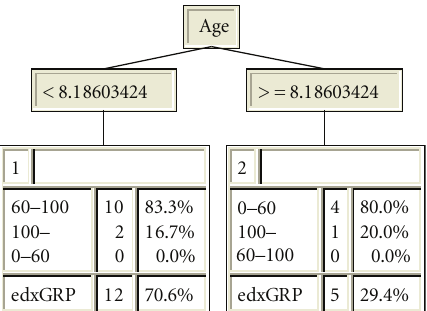
Figure 7: Knowledge tree generated in XpertRule Miner. At the top of the tree is the attribute “Age” located with the break points for the two end leaves with the group names, frequency within each group and percentage correctly classified examples. The last row shows the total frequency of examples and the overall correctly classified